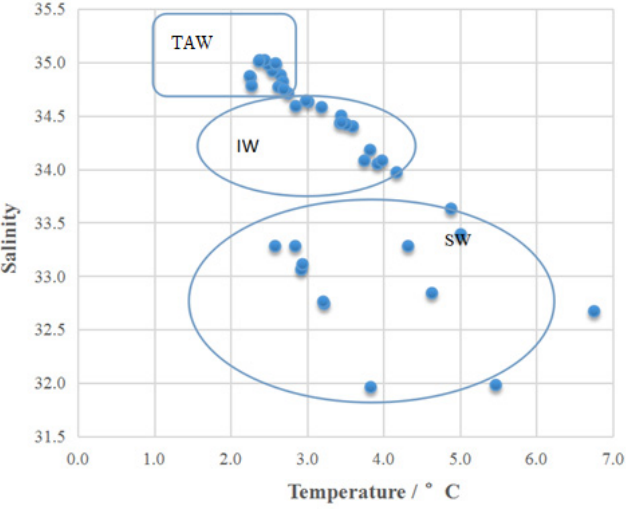
Figure 2. Composition of water masses at the five stations in the Kongsfjorden: SW: Surface Water, Figure 2. The distribution of temperatures (°C) and salinity, and water masses at the five stations IW: Intermediate Water, and TAW: Transformed Atlantic in the Kongsfjorden: SW: Surface Water, IW: Intermediate Water, and TAW: Transformed Atlantic Water.